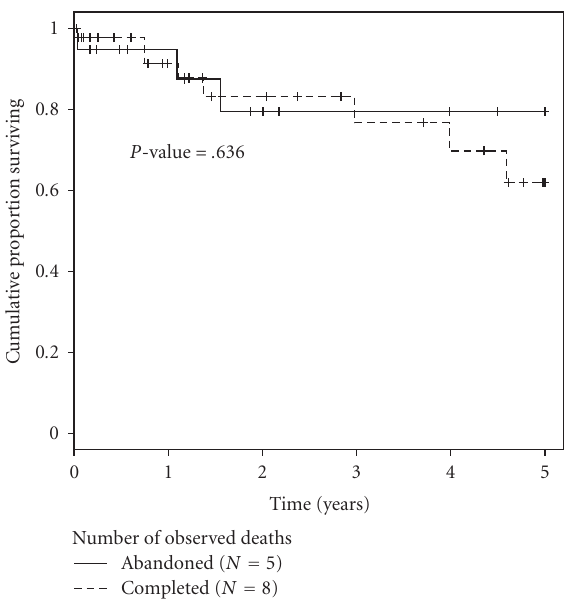
Figure 2: Overall survival at five years for abandoned hysterectomy and completed hysterectomy